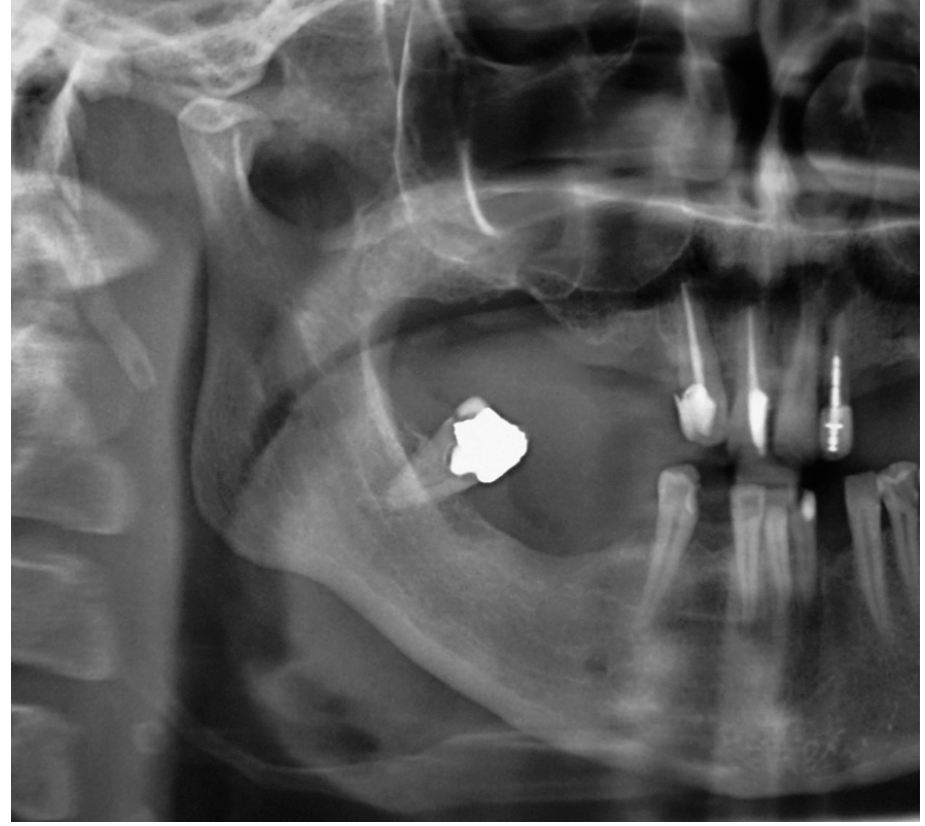
Figure 2. Cropped panoramic image showing resected styloid process.